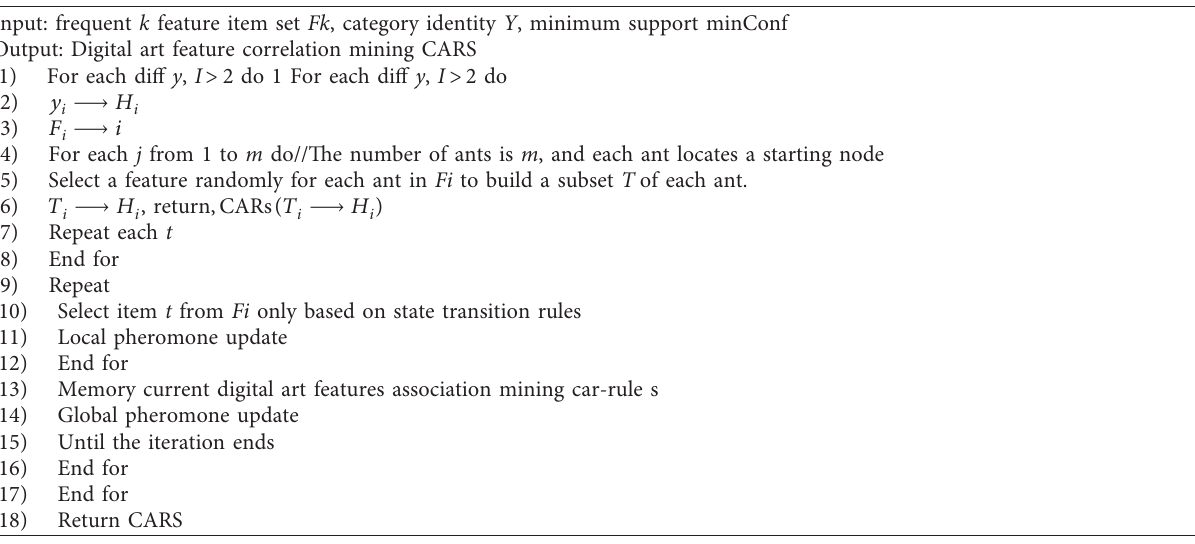
Table 1: Digital art feature association mining algorithm based on the improved machine learning algorithm.